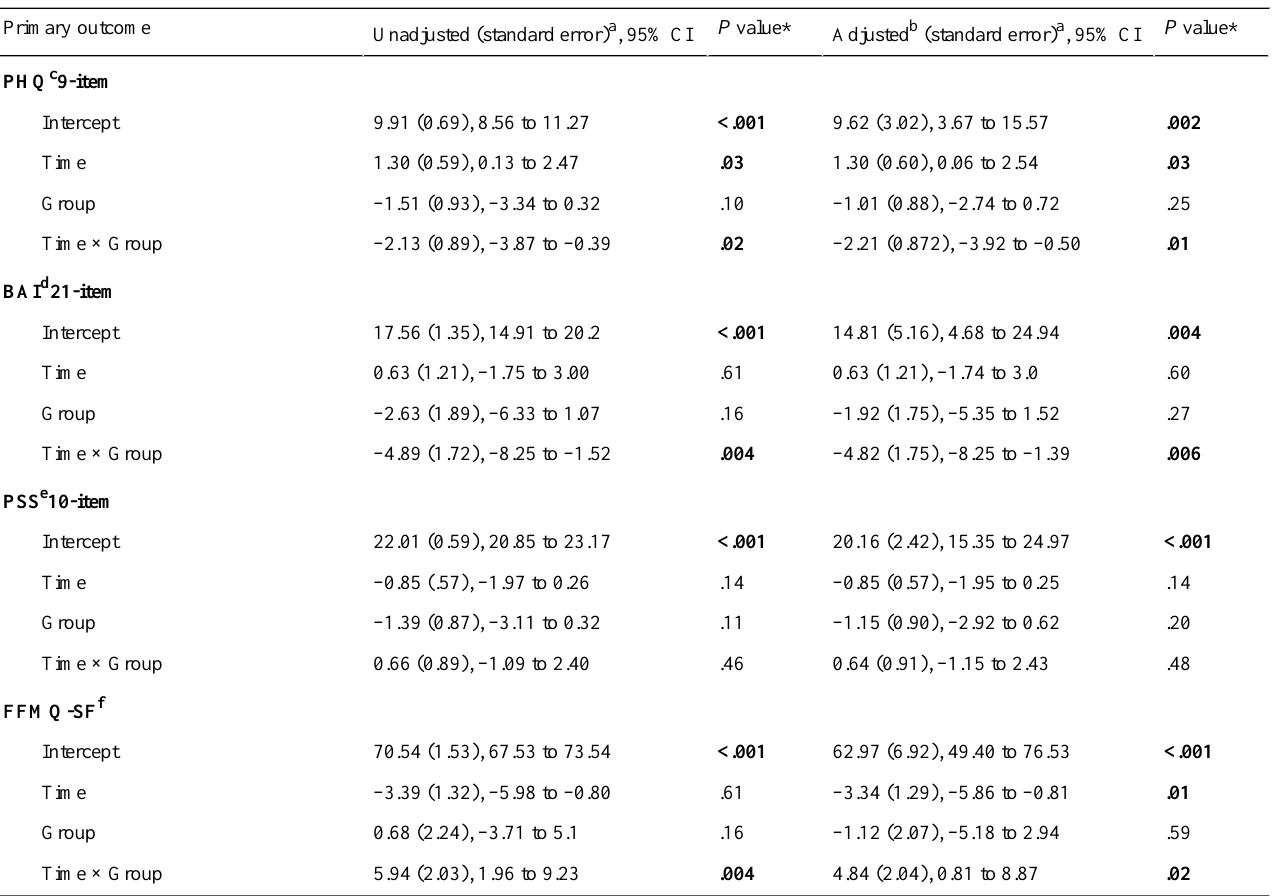
Table 4. Generalized estimation equation with multiple imputation for depression, anxiety, stress, and mindfulness scales (Model 1: unadjusted and Model 2: